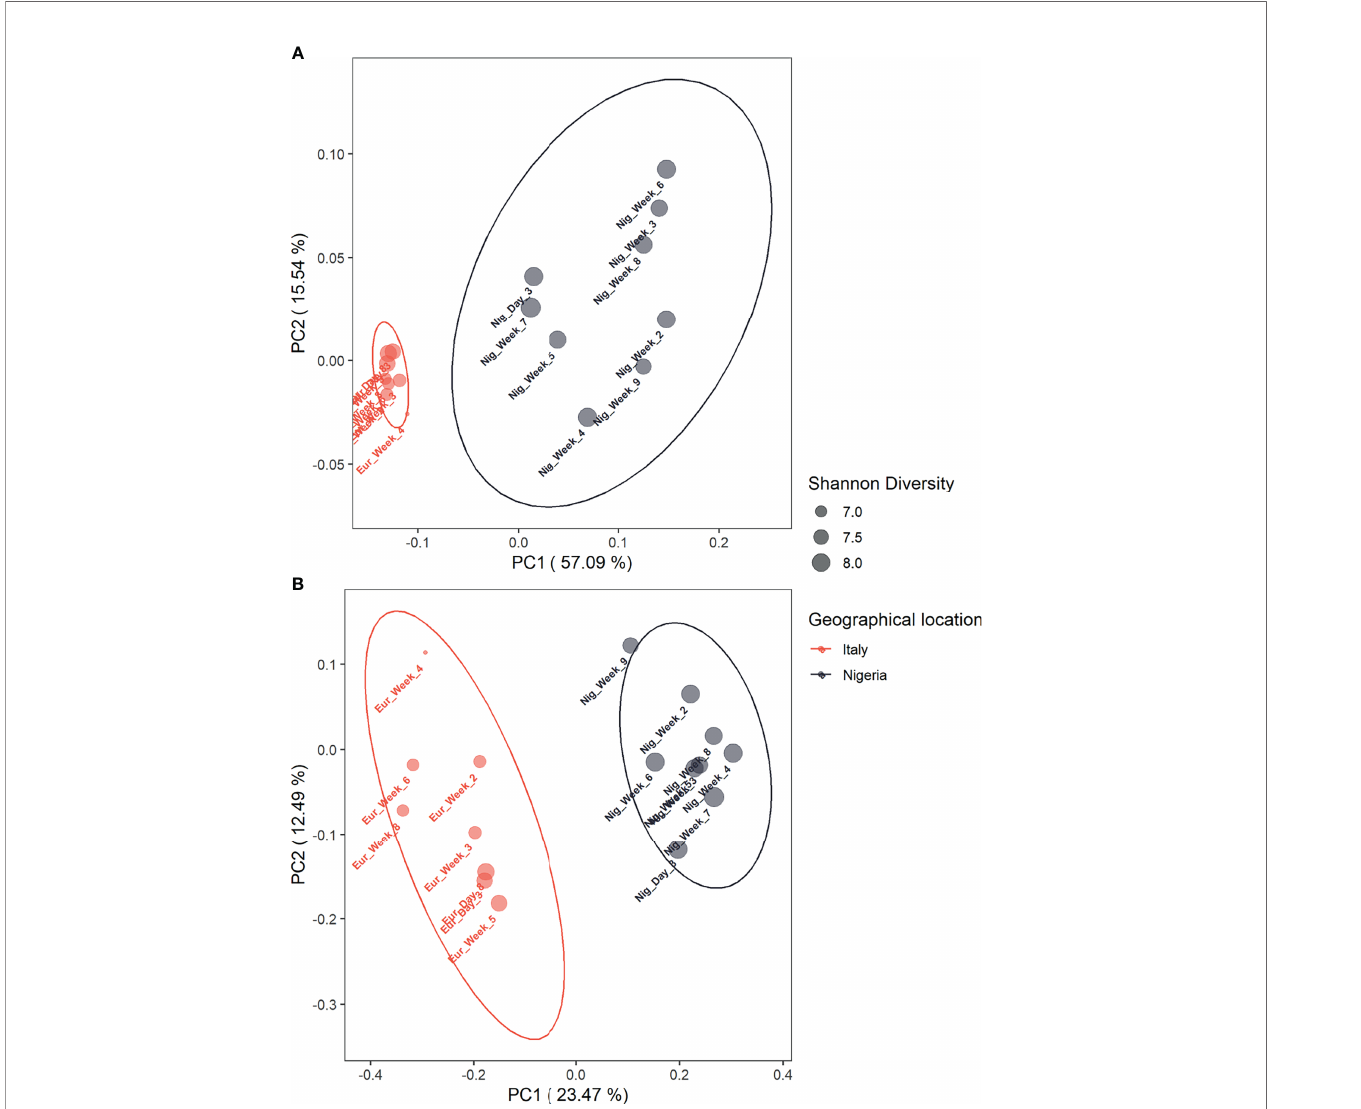
FIGURE 2 | The compositional structure of an individual ’ s gut microbiota while in Italy segregates from the pro fi le associated with life in Nigeria. Principal Coordinates Analysis based on weighted (A) and unweighted (B) UniFrac distances between the Italian and Nigerian gut microbiota pro fi les shows signi fi cant segregation (p = 0.001; PERMANOVA). Samples were labelled by day or week of collection (see Supplementary Table 1 ) and coloured by geographical location. Ellipses include 95% con fi dence area based on the SE of the weighted average of sample coordinates and are colored by geographical location (Italy: red, Nigeria: black). Dot size is proportional to the Shannon index, as shown in the